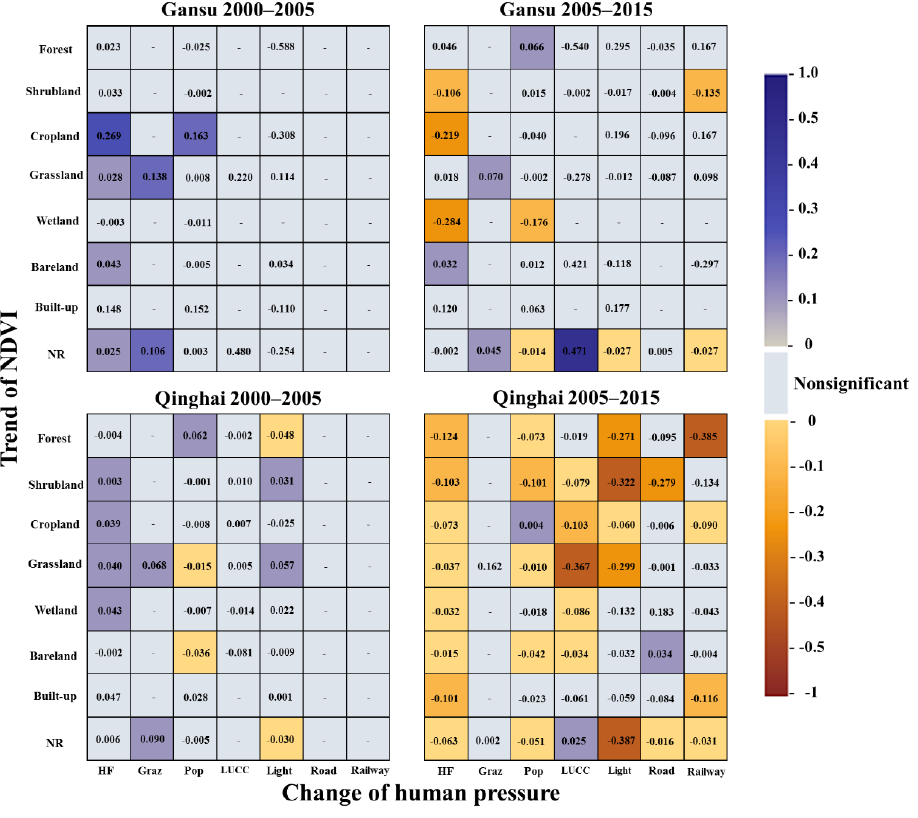
Figure 8. Relationships between the trends of different vegetation types and changes in the HF and six categories of hu- man pressures for 2000–2005 and 2005–2015 in Gansu and Qinghai. The blue regions indicate significant positive corre- lations ( p < 0.05), and the correlation coefficient increases with darkening color; the red regions indicate significant posi- tive correlations ( p < 0.05), and the correlation coefficient increases with darkening color. Gray regions denote nonsignif- icant correlations ( p > 0.05). The number in the bin is the correlation coefficient.